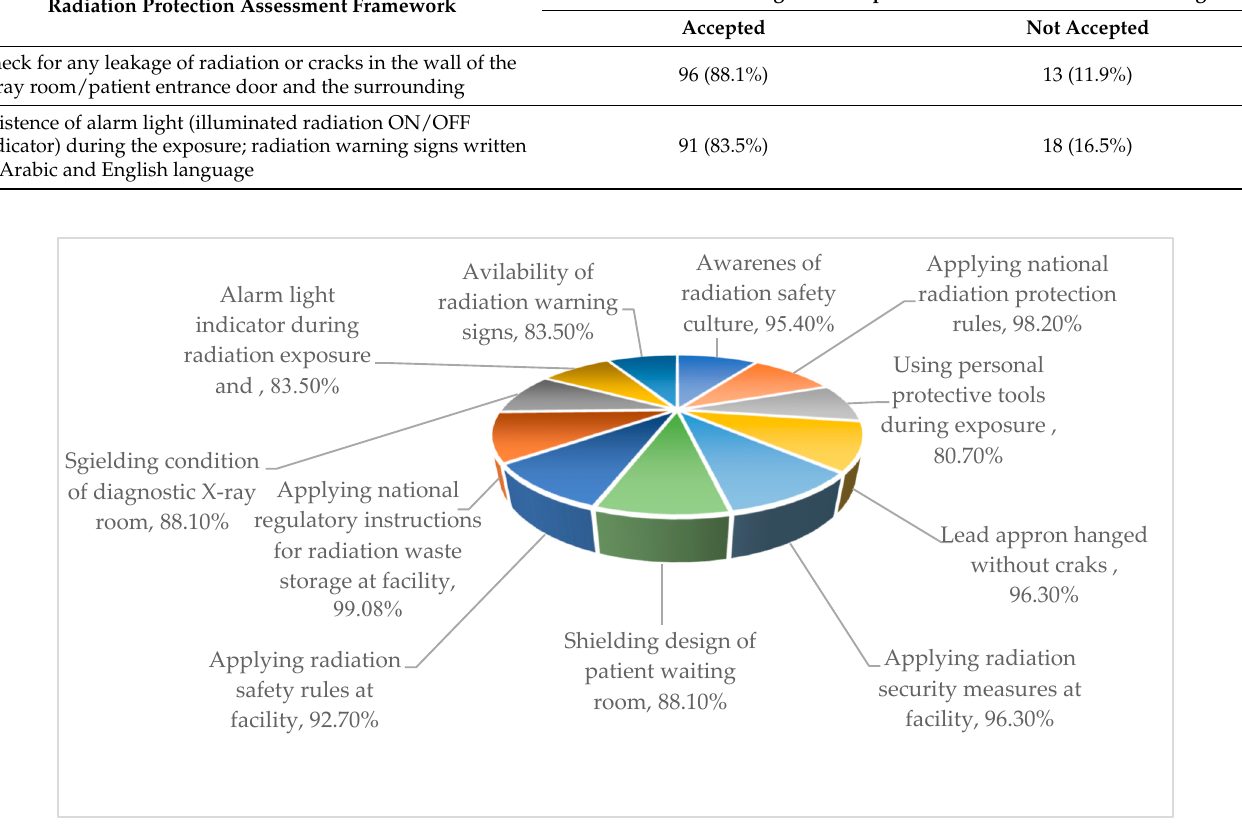
Figure 2. Contribution of each (accepted) category of radiation protection measure to the total inspected facilities with percentage. Table 2. Checklist of the observed and registered radiation protection measures during the inspec- tion of the facilities.